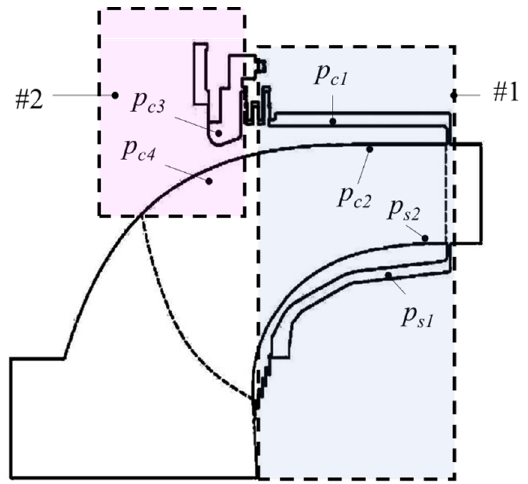
Figure 14. Meridional map of runner with indication of hub and crown leakages.